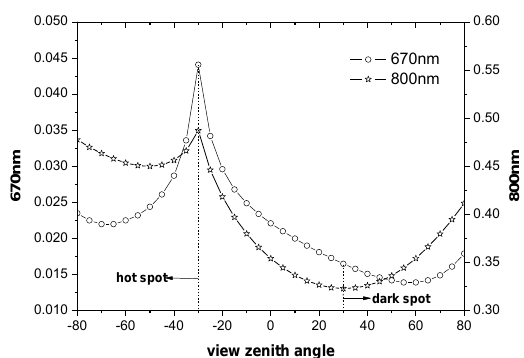
Figure 2. Changes of reflectance in 670 nm and 800 nm